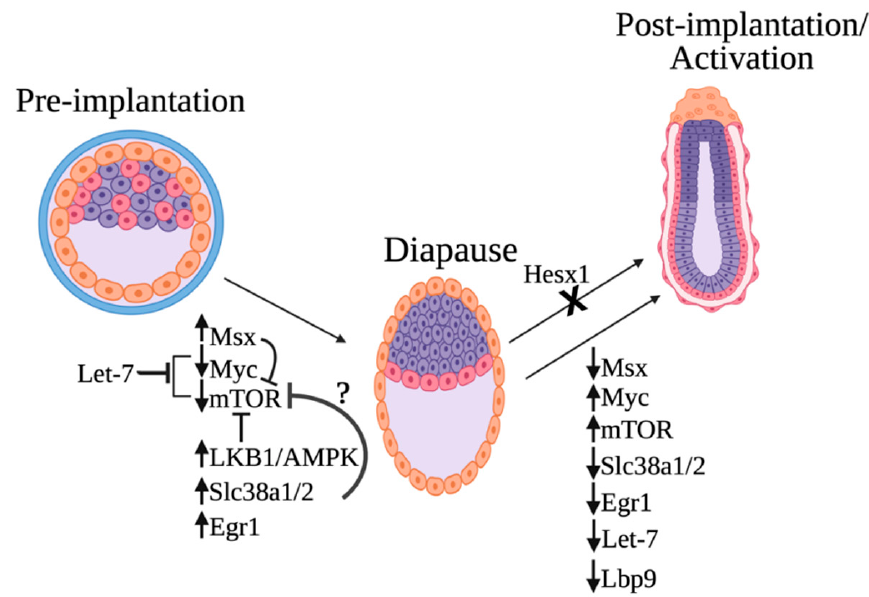
Figure 2. Proposed model of embryonic diapause molecular regulation. Induction of diapause is caused by the elevated levels of Msx1, Egr1, and the glutamine transporters Slc38a1/2 and the downregulation of Myc and mTOR. The starvation-induced Lbk1–AMPK axis is also critical for mTOR inhibition. The microRNA let-7 is highly upregulated in diapause and induces embryonic diapause by inhibiting both Myc/mTORC1 and mTORC2. Msx can potentially repress mTOR, and Slc38a1/2 might also inhibit the activation of the mTOR complex. Downregulation of Tfcp2L1/Lbp9 and metabolic switch takes place during exit from diapause. Furthermore, mutation of the transcriptional repressor Hesx1 in diapause disrupts exit from embryonic diapause and continuation of embryonic development after implantation. This figure was created with biorender.com (accessed on 1 May